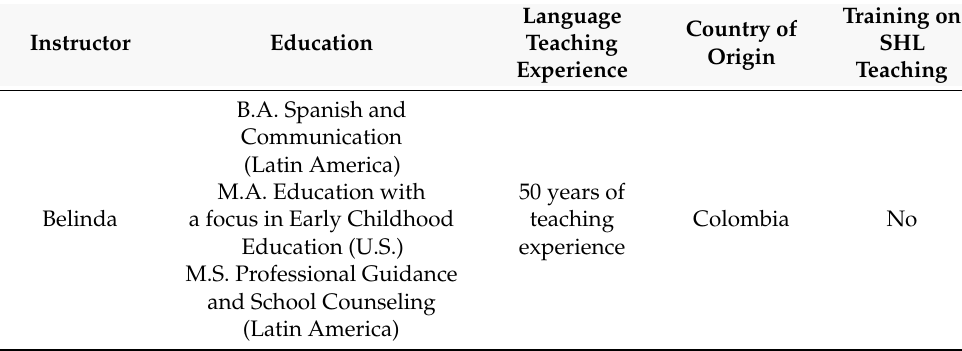
Table 2. Instructor Background